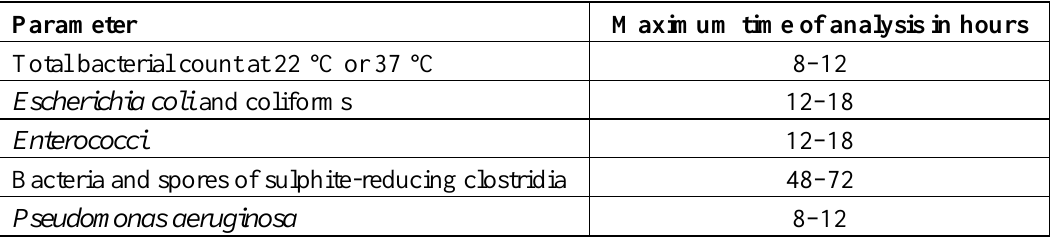
Table 4. Maximum time of analysis between sampling and